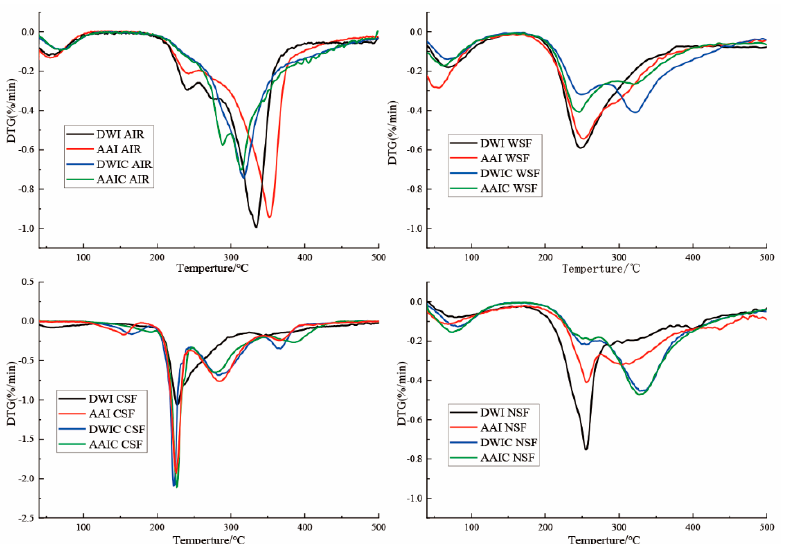
Figure 6. DTG analysis of cell wall fractions and AIR in different treatment groups. DWI: distilled water immersion for 15 h; AAI: 0.6% acetic acid immersion for 15 h; DWIC: cooked DWI; AAIC: cooked AAI; WSF: water − soluble fraction; CSF: chelate − soluble fraction; NSF: sodium carbonate − soluble fraction; HF: hemicellulose fraction.